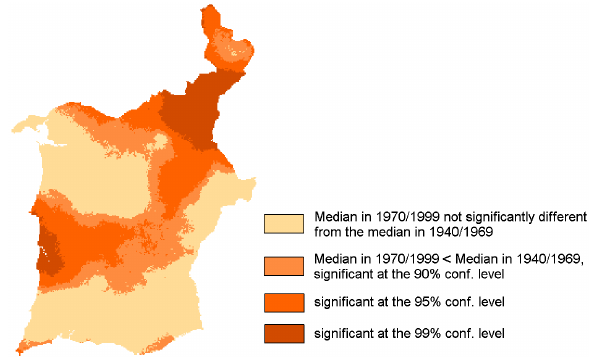
Fig. 4. Wilcoxon-Mann-Whitney tests results for the 12-month SPI. 2